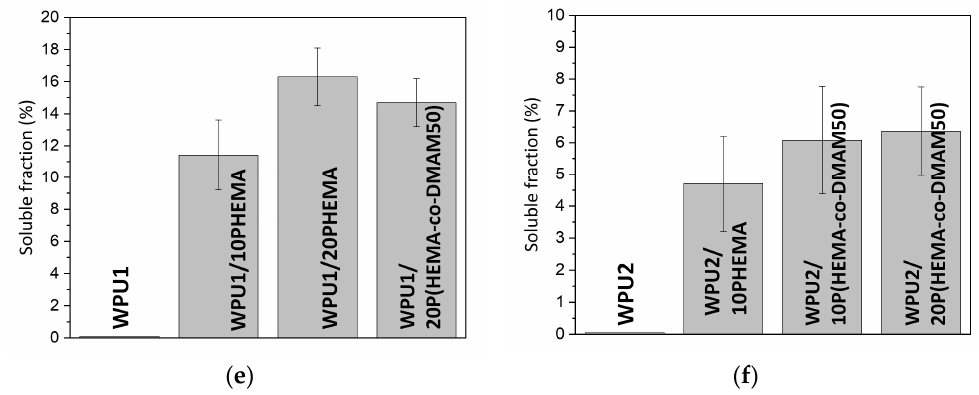
Figure 6. Water uptake of WPU and WPU/polymer films: ( a ) WPU1, WPU1/xPHEMA and